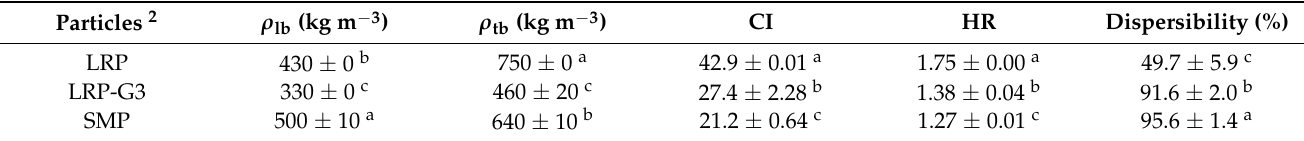
Figure 6. SEM images of ( a ) SMP, ( b ) LRP, and ( c ) LRP-G3. Table 1. Loose bulk density ( ρ lb ), tapped bulk density ( ρ tb ), Carr Index (CI), Hausner ratio (HR), and dispersibility of LRP, LRP-G3, and SMP 1